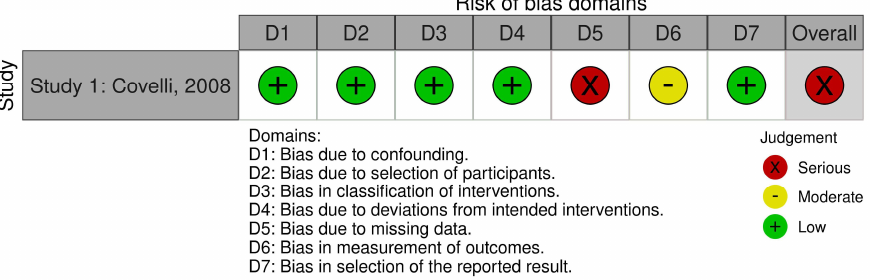
Figure 2. Risk of Bias ‘Traffic light’